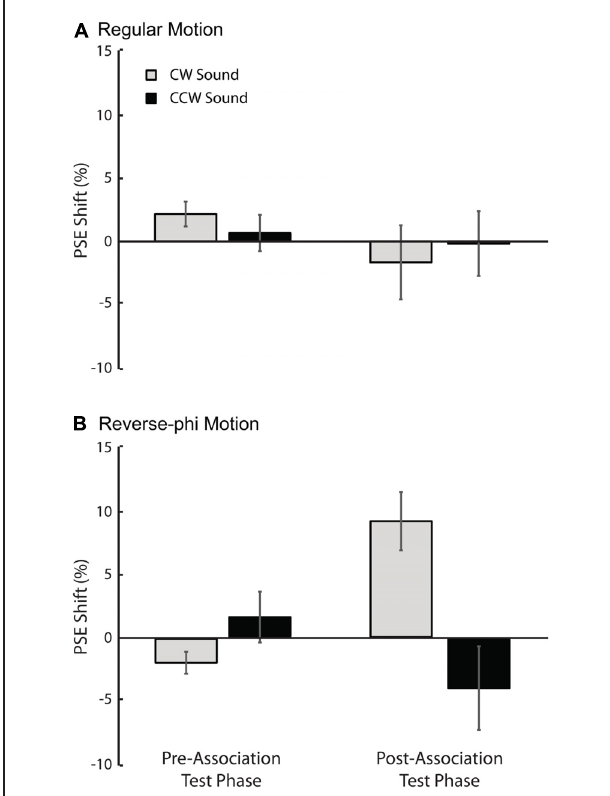
FIGURE 5 | Results of Experiment 2 (reverse-phi motion used in the association phase). The averaged PSE shifts of all observers as a function of test phase. (A) Pre-association and post-association data for regular motion. (B) Pre-association and post-association data for reverse-phi motion. The gray and black bars represent CW and CCW sound conditions, respectively. Error bars indicate +